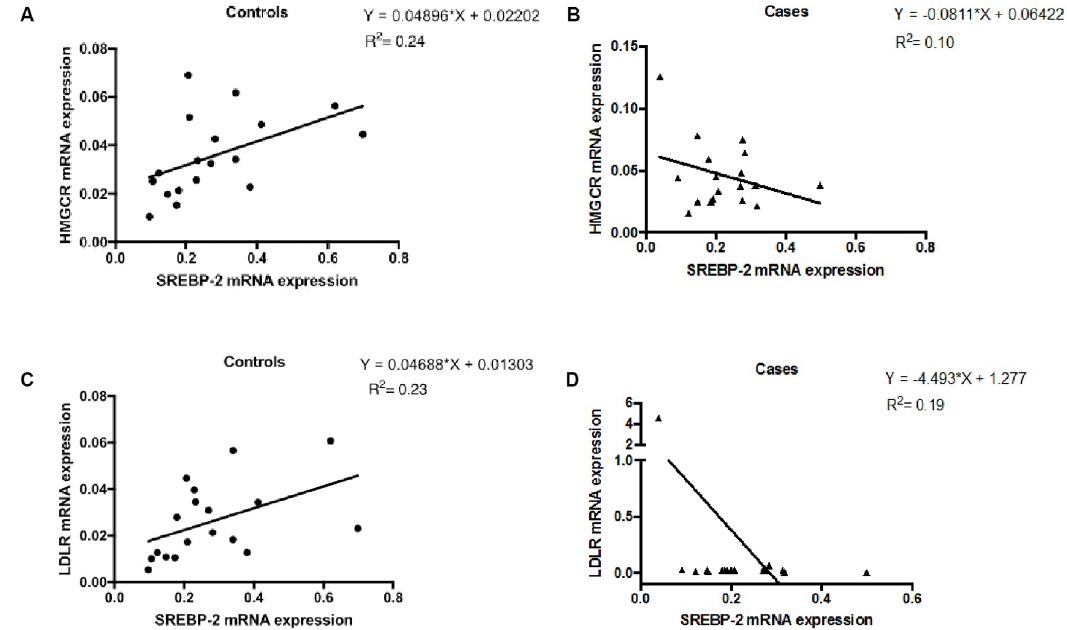
Fig 3. Correlation analysis of mRNA expression of cholesterol biosynthesis genes in peripheral blood mononuclear cells (PBMCs) of participants. HIV positive individuals on ART (cases, n = 18) and HIV negative individuals (controls, n = 18). Linear regression analysis was performed and significance was noted for p values < 0.05. R 2 values are reported for correlations with significance. A. The mRNA expression of SREBP-2 vs. HMGCR in controls. B. The mRNA expression of SREBP-2 vs. HMGCR in cases. C. The mRNA expression of SREBP-2 vs. LDLR in controls. D. The mRNA expression of SREBP-2 vs. LDLR in cases.